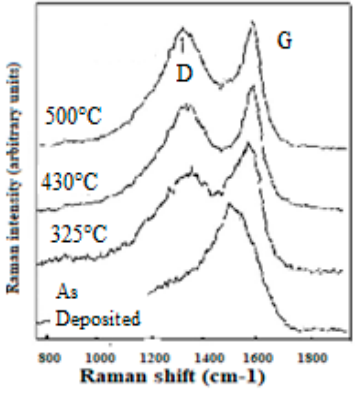
Figure 9. Annealing of H rich a-C:H. As grown, a-C:H ~70 cm − 1 tensile down shift owing to H 2 exodiffusion. With annealing, stress is reduced and Csp2 clusters grow (G peak) A GeA band (Csp2 cluster edge) appears beside a growing diamond peak (~1325 cm − 1 ) (an H6 diamond). By Wagner et al. [130] with permission of Les Editions de la Physique.